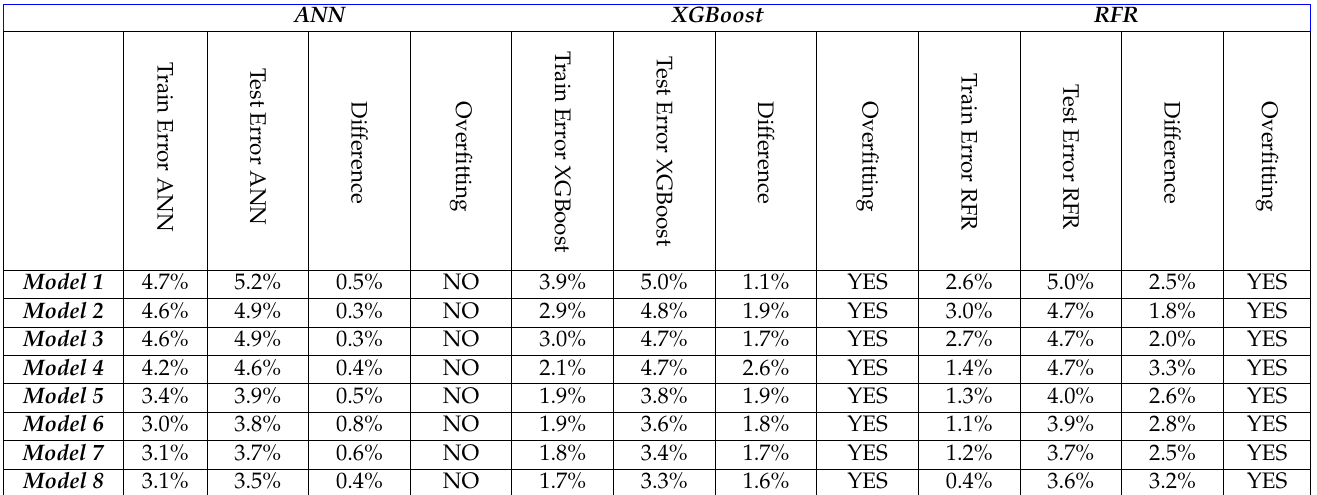
Table 9. Train and test errors of ANN, XGBoost, and RFR.